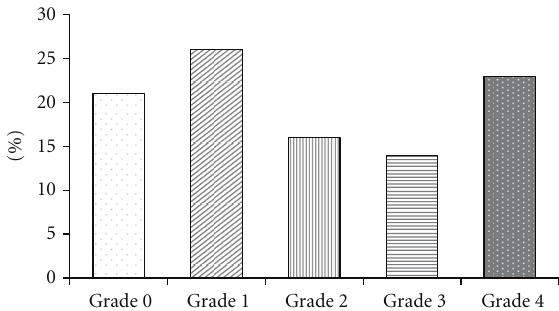
Figure 4: Distribution of aortic calcification grading. The bar graph illustrates the distribution of aortic calcification grading. Aortic arch calcification was distributed relatively